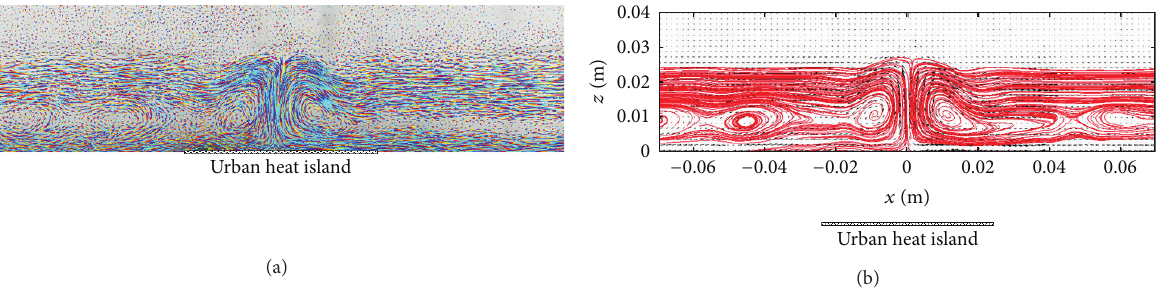
Figure 31: Diurnal UHI: (a) particle trajectories reconstructed by FT; (b) time-averaged Eulerian velocity vectors and